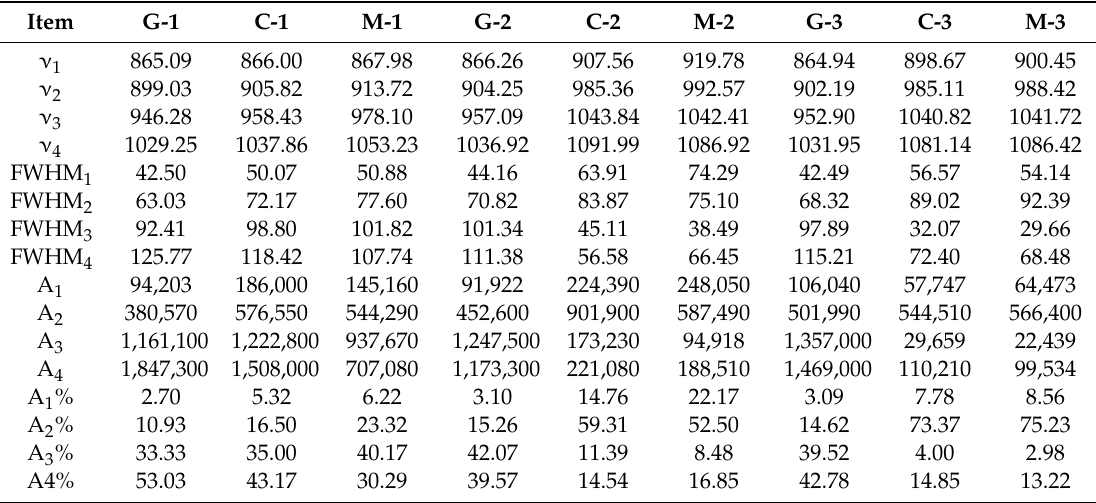
Table 3. Frequencies ( ν n ), FWHM (cm − 1 ), and area% (A n %) of Raman bands obtained from the deconvolution fits.